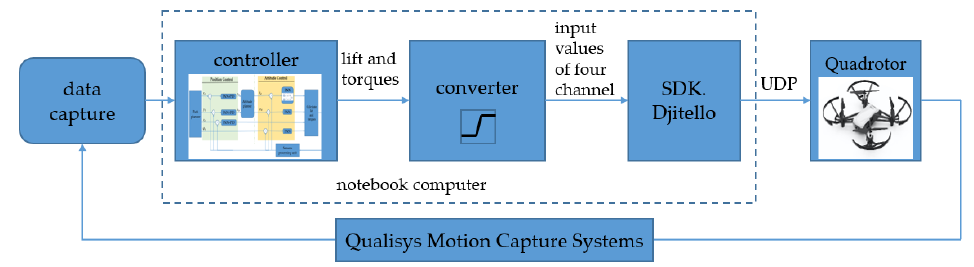
Figure 10. Experimental process using a Tello quadrotor.